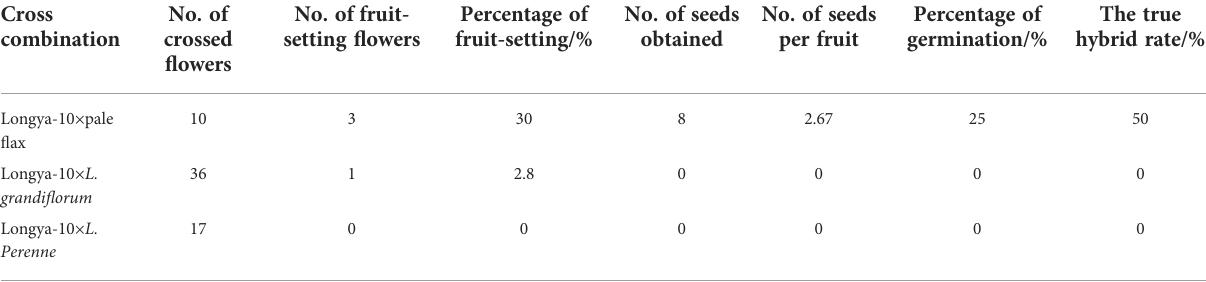
TABLE 1 Comparison of characteristics between different crosses. Cross No. of combination